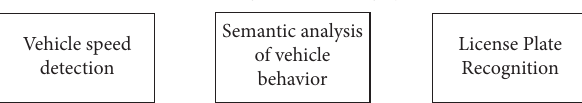
Figure 3: Overall design block diagram of the intelligent trans- portation system.